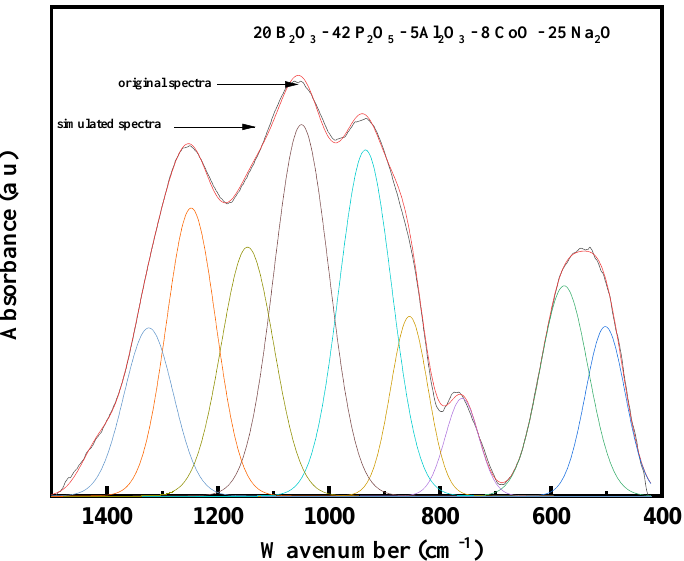
Figure 4. Curve fitting of FTIR spectra of the glasses 49P 2 O 5 –20B 2 O 3 –5Al 2 O 3 –25Na 2 O–1CoO.